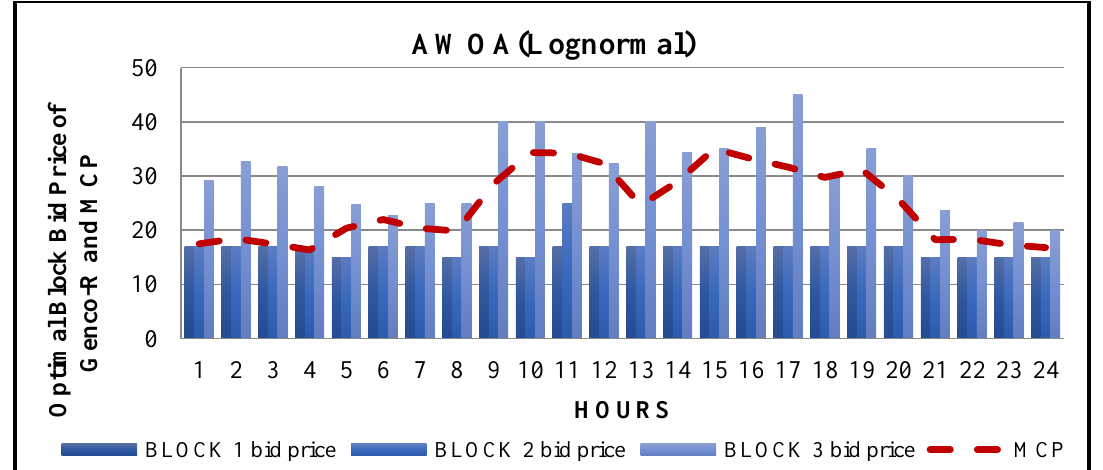
Figure 13. AWOA (Lognormal Distribution) Block Bid Price and MCP.